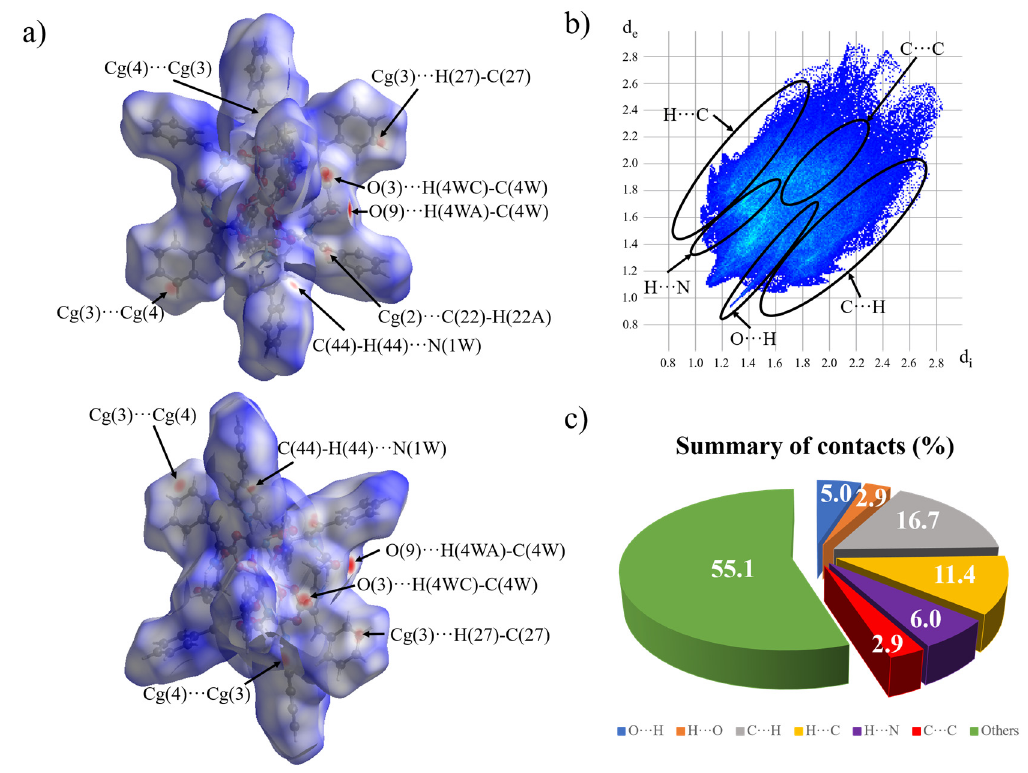
Figure 7. ( a ) Hirshfeld surface d norm representations, ( b ) 2D fingerprint plot highlighting the intermolecular interactions, and ( c ) graphical summary of the percentage of each contact involved in the Hirshfeld surface of 2 ·4CH 3 CN.